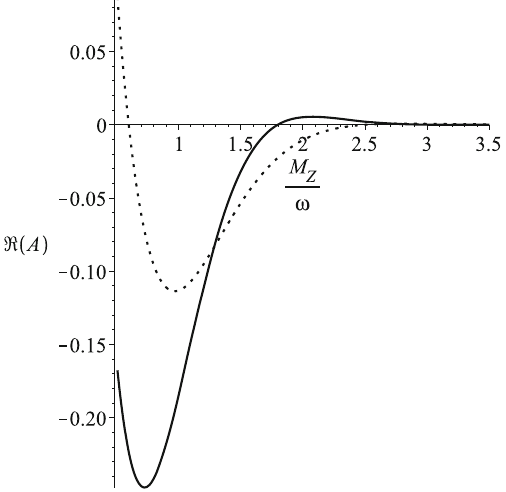
Fig. 1 Real part of A k as a function of parameter M Z /ω . Solid line is for p = 0 . 5 , p (cid:11) = 0 . 4 , P = 0 . 1, while the point line is for p = 0 . 5 , p (cid:11) = 0 . 3 , P = 0 .